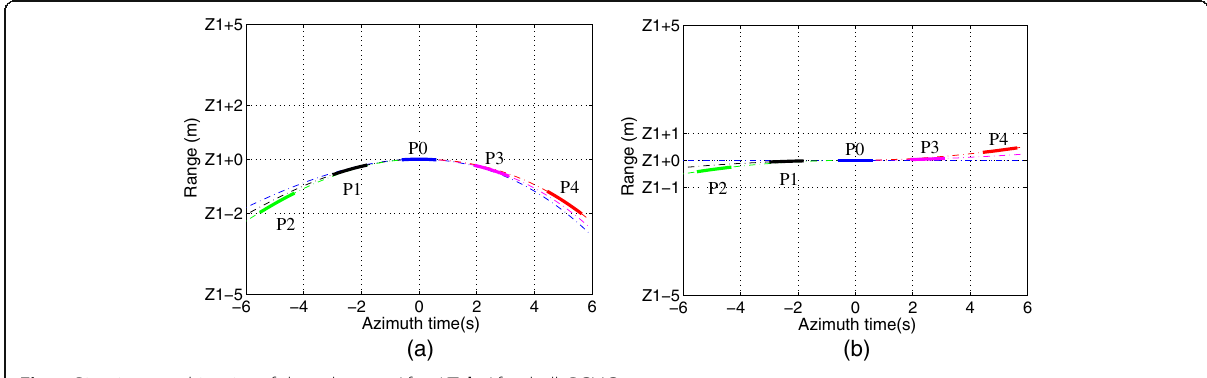
Fig. 7 Bistatic range histories of the echoes. a After KT. b After bulk RCMC